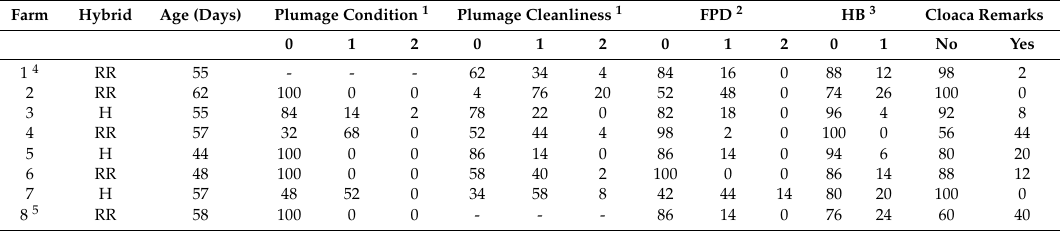
of the fitted models were found to be adequate. No toe damages were observed in any of the birds. Table 2. Proportion (%) of chickens ( n = 50) in each flock ( n = 8) with different plumage condition, plumage cleanliness, foot pad dermatitis (FPD) and hock burn (HB) scores and cloaca remarks (signs of enteritis/diarrhoea) (Welfare Quality ® ) on Swedish organic broiler farms. (H: Hubbard; RR: Rowan Ranger). Farm Hybrid Age (Days) Plumage Condition 1 Plumage Cleanliness 1